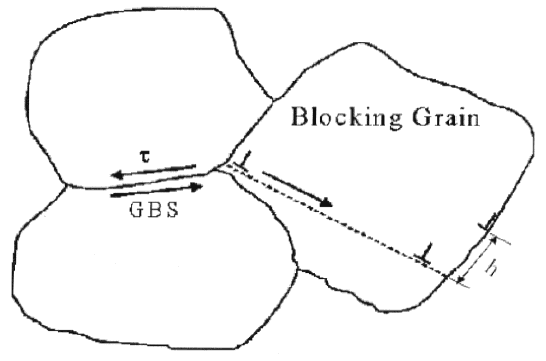
Figure 19. Schematic diagram for the model of dislocation-accommodated boundary sliding, showing that as a result of boundary sliding, dislocations are generated at a triple junction and then traverse the grain to the opposite grain boundary where they climb and are